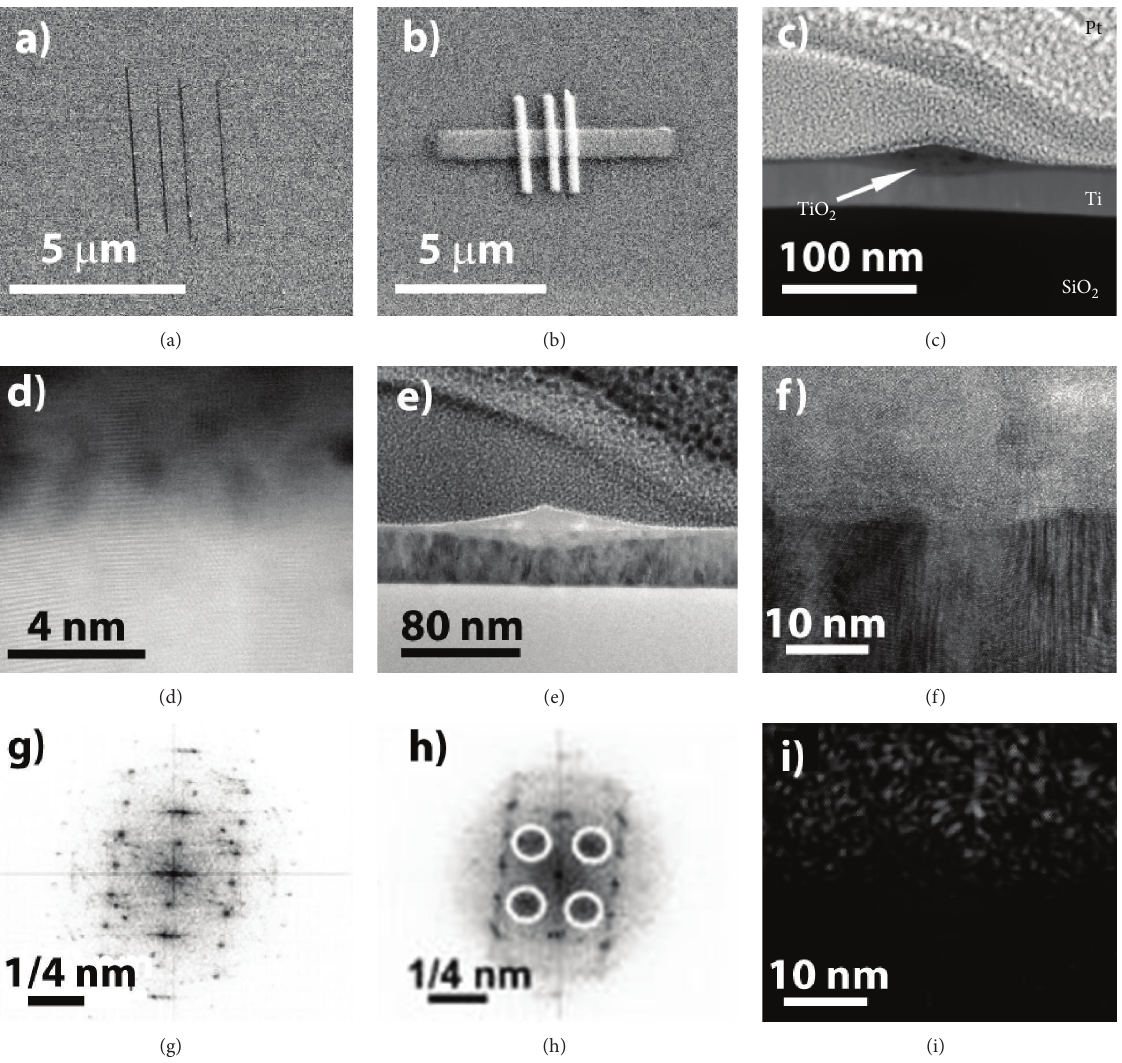
Figure 2: Images of high-resolution electron microscopy and related techniques of the titanium oxide line sensor active region. (a) SEM image of four Ti oxide lines. (b) SEM image of the same region as in Figure 2(a) after Pt deposition of the protective layer on the top of three lines. (c) HAADAF image in STEM mode of the lamella showing a cross-section of the titanium oxide line. (d) HAADAF high-resolution image of the bottom metallic-oxide interface. (e) TEM image of the same region showed in Figure 2(d). (g) High-resolution TEM image of the same region showed in Figure 2(d). (f) FFT image of the Ti in the most lower part of Figure 2(f). (h) FFT image of the Ti oxide in the upper part of Figure 2(f). (i) HRTEM image showing the titanium oxide nanocrystals after applying a bypass filter in FFT of the four spots circled in Figure